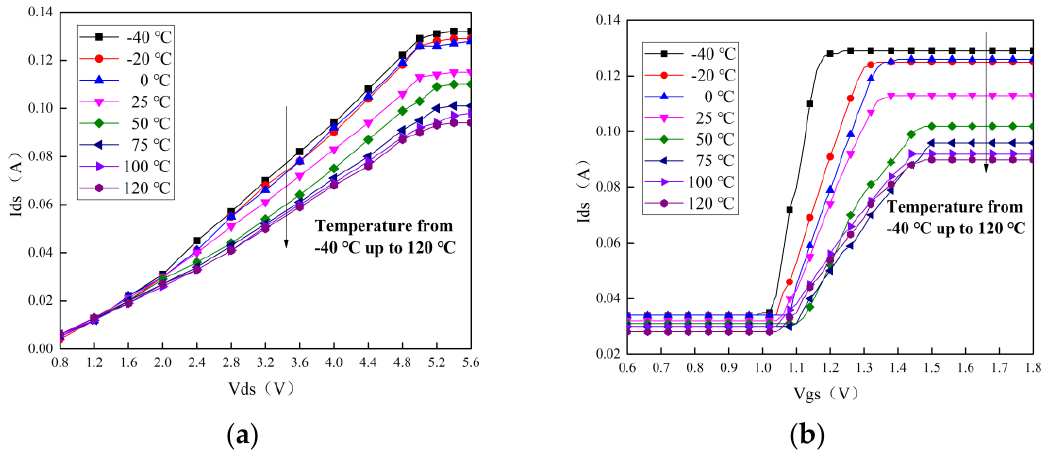
Figure 9. Measured DC characteristics curves of the GaAs pHEMTat different temperatures: ( a ) the output characteristic; ( b ) the transfer characteristic.